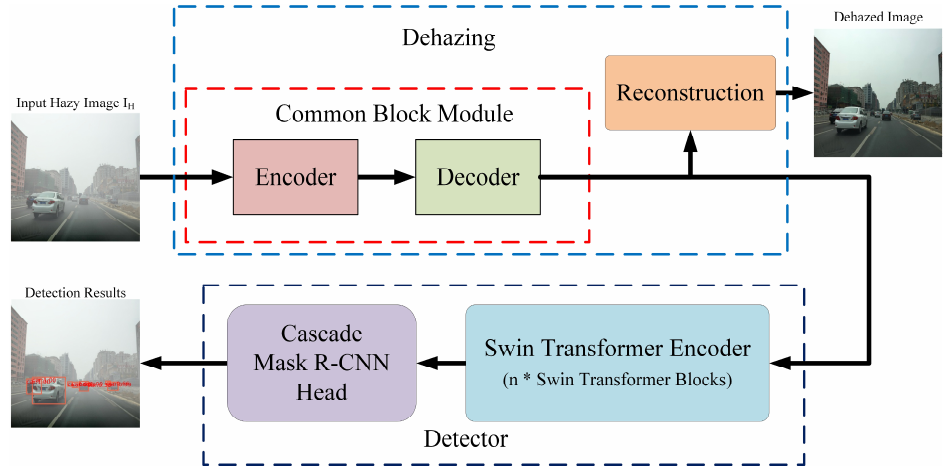
Figure 3. The architecture of our method. The framework consists of two subnetworks: the dehazing network and the detection network.